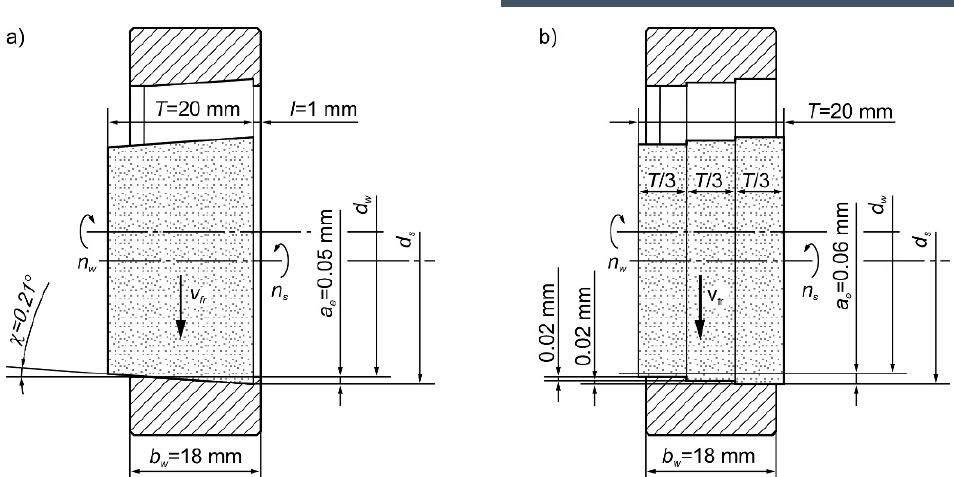
Figure 1. Kinematics of the method of comparative assessment of the grinding wheel cutting ability and grinding wheels, with special macrogeometry, used in it: a) conical grinding wheel; b) grinding wheel with zones of various diameters.